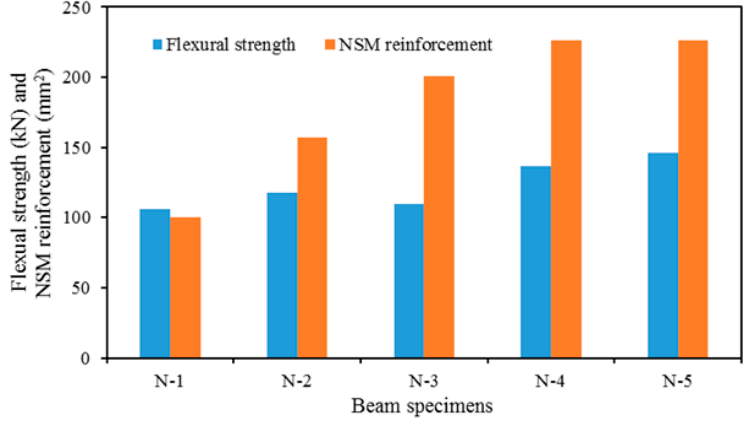
Figure 10. The effect of NSM reinforcement amount.